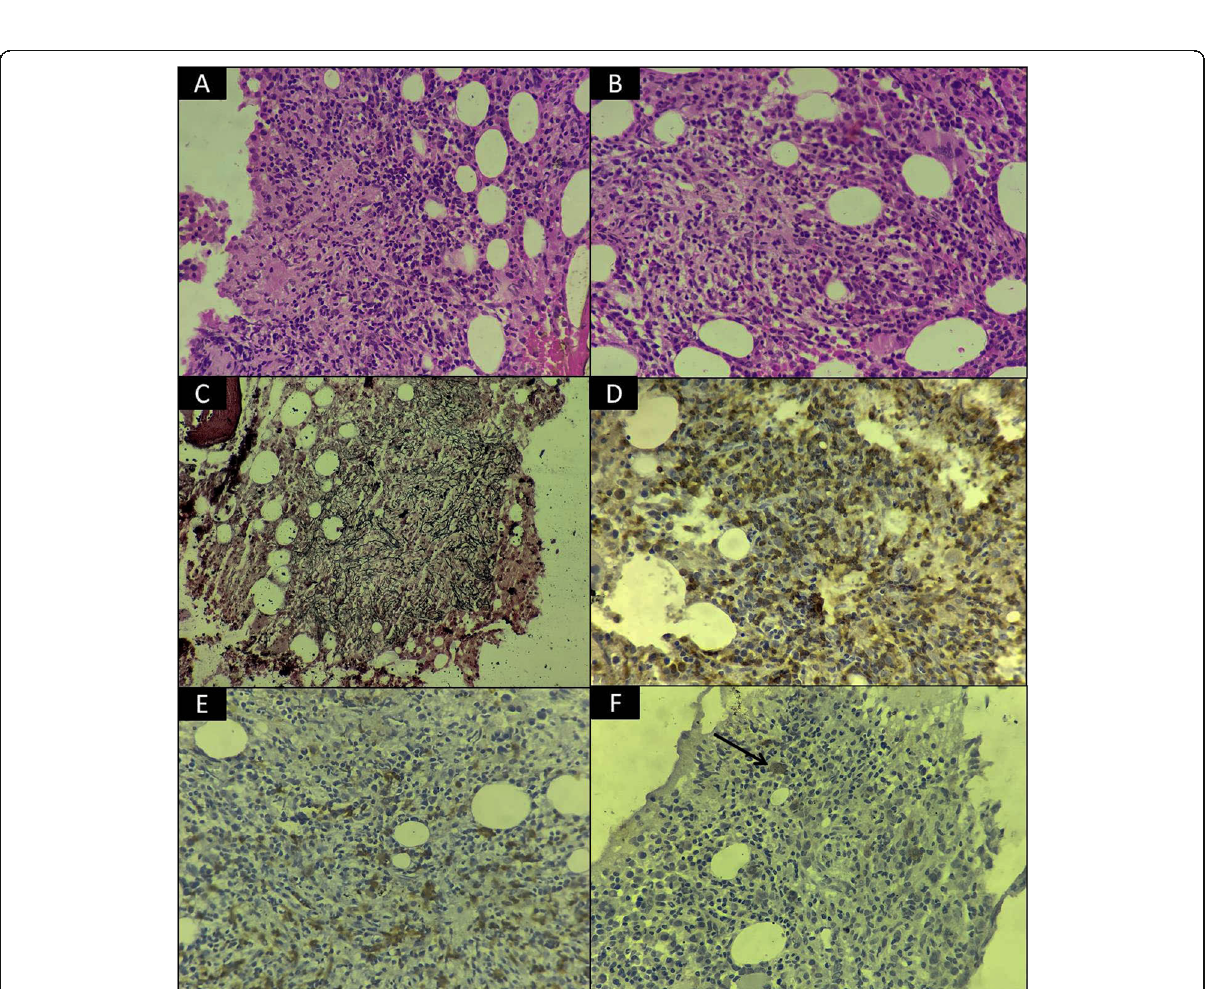
Fig. 3 Showing bone marrow biopsy